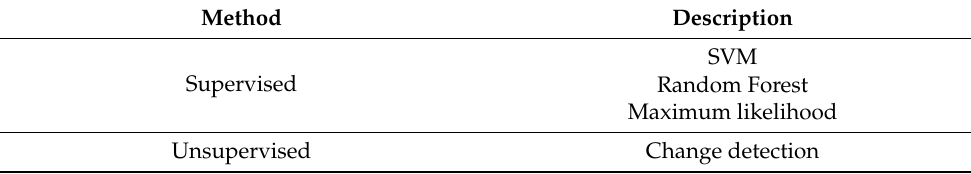
Table 2. Machine-learning based techniques used in the present